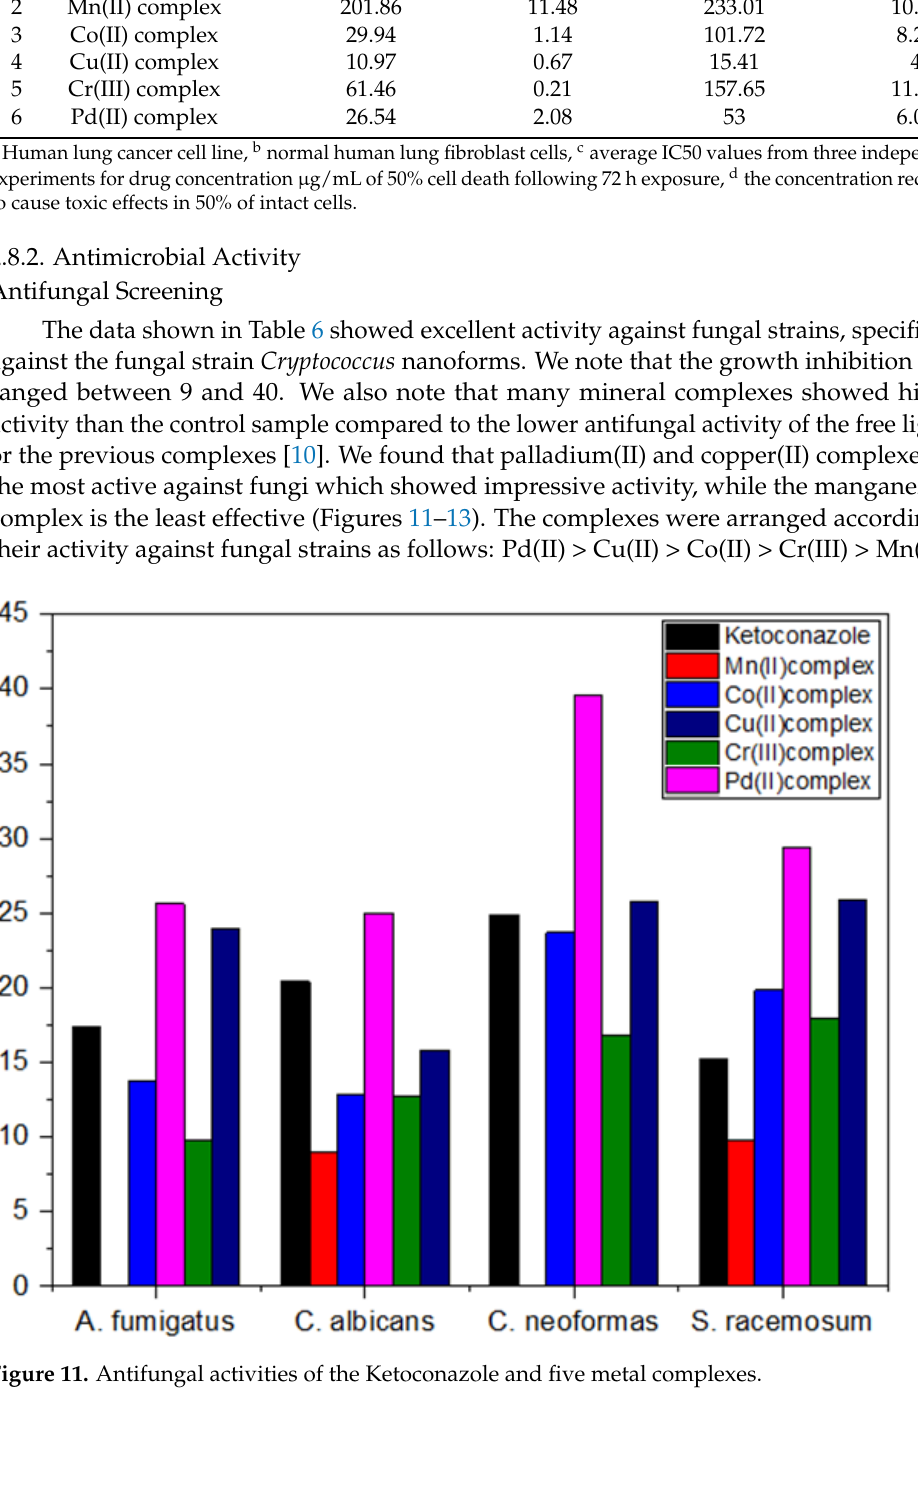
Figure 12. Microbiological screening of coordination compounds of Mn(II), Co(II), Cu(II), Cr(III), and Pd(II) toward Cryptococcus neoformas.